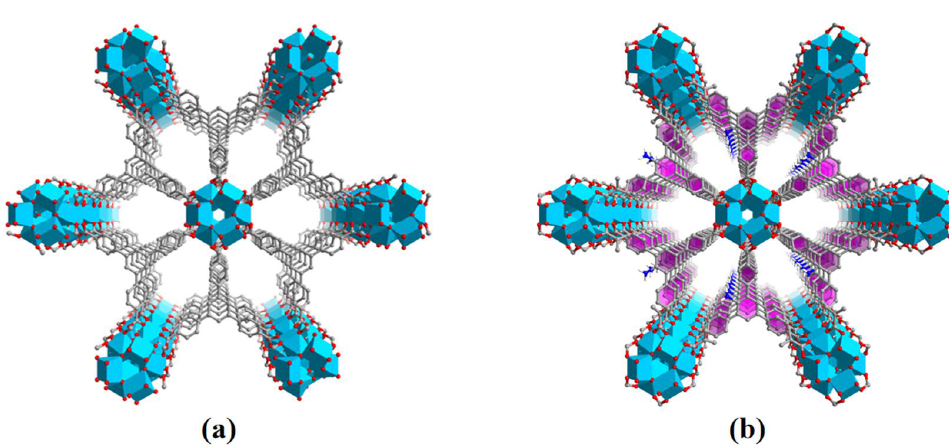
Figure 1. Crystal structures of the ZSTU-2 ( a ) and NH 2 -ZSTU-2 ( b